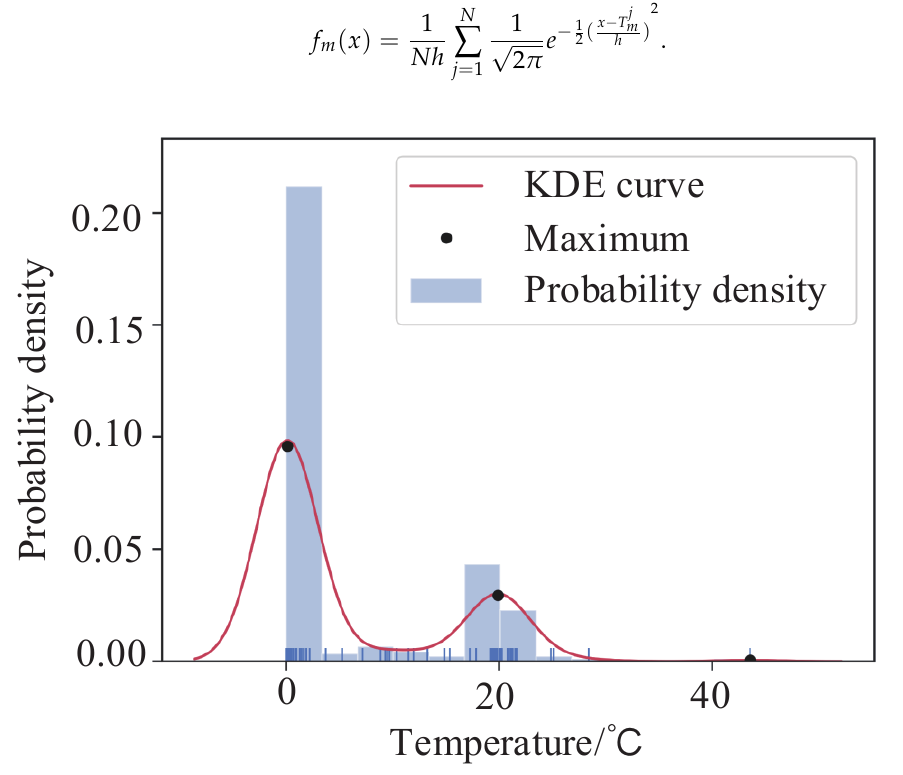
Figure 3. Temperature probability density distribution of c m . After that, the temperature probability density distribution function is visualized in Figure 3 by the red curve. The point of local maximum O q m (( x q m , y q m ) , q = 1, 2, . . . , Q ) is obtained, which is denoted by the black dots in Figure